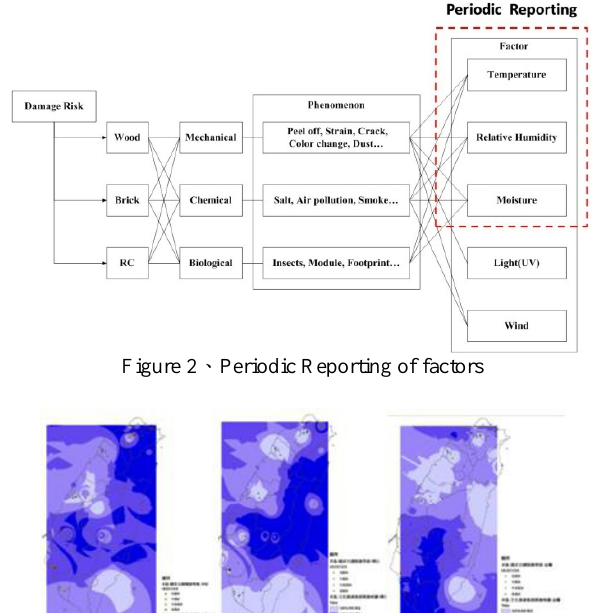
Figure 3 、 Taiwan Heritage Risk Maps(Wu, Ping-Sheng ， 2012)